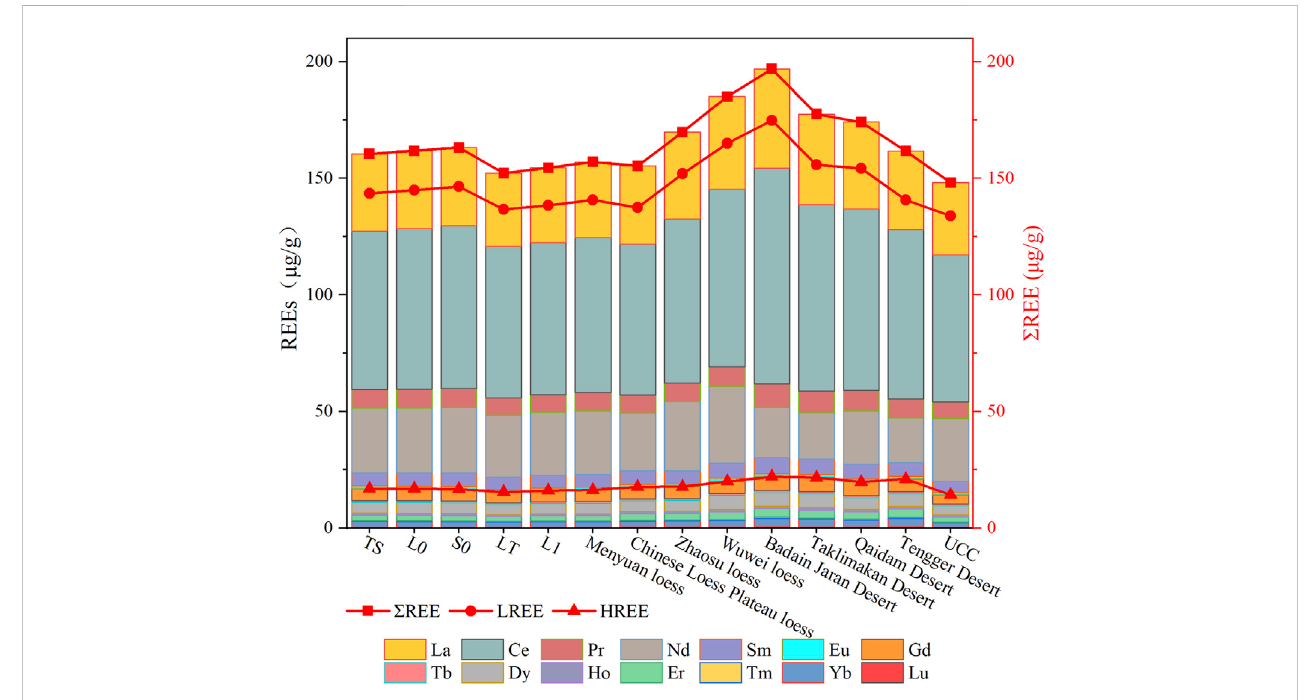
Comparison diagram of the contents of each rare Earth element in samples from different strata in the YHC pro fi le and other